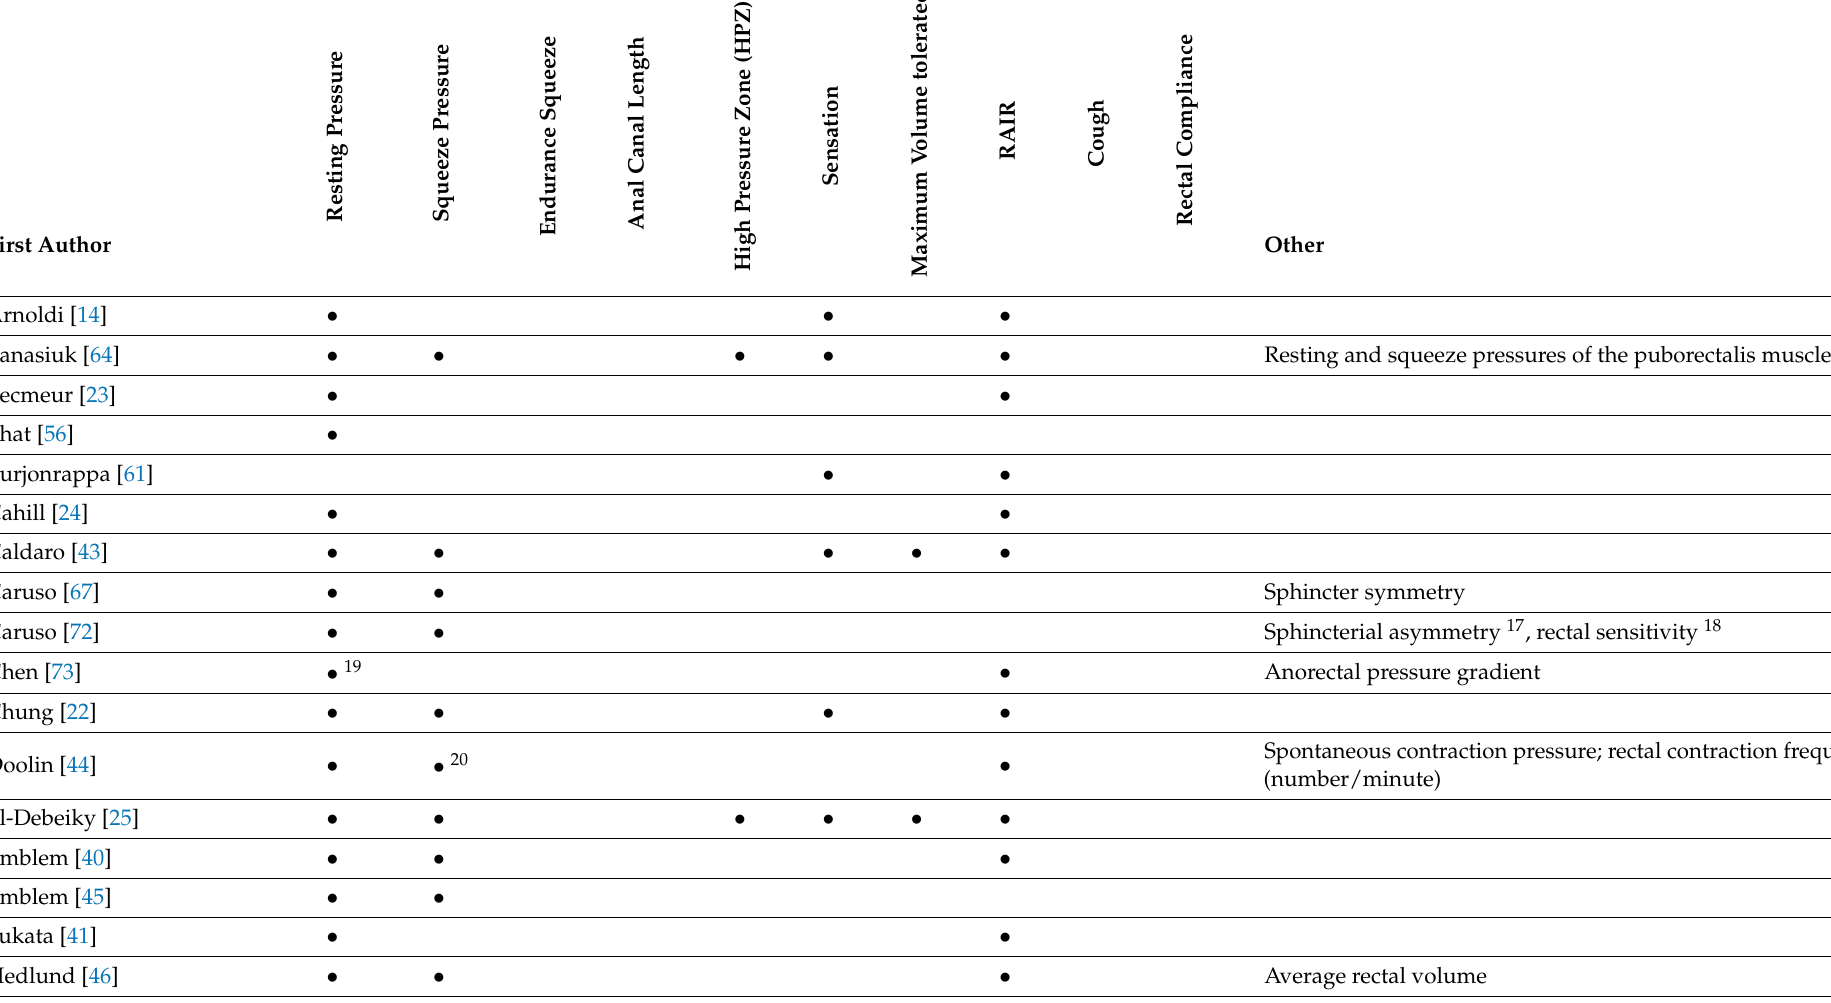
Table 3. Reported anorectal manometry parameters. Comparable parameters are